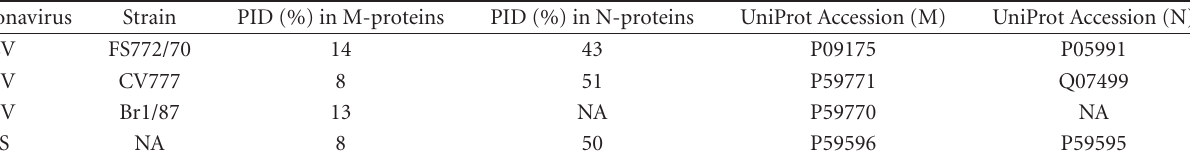
Table 2: The PID values in the M- and N-proteins of various porcine coronaviruses and SARS-CoV. The SARS-CoV values are shown here for the comparison.